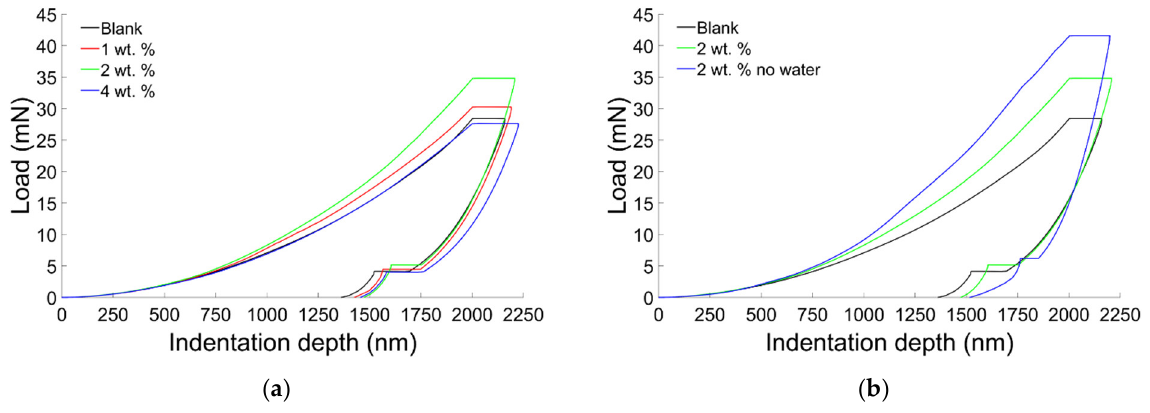
Figure 11. ( a ) Representative curves of nanoindentation tests performed on samples obtained using water. ( b ) Comparison between representative curves of nanoindentation tests carried on samples obtained with and without water.